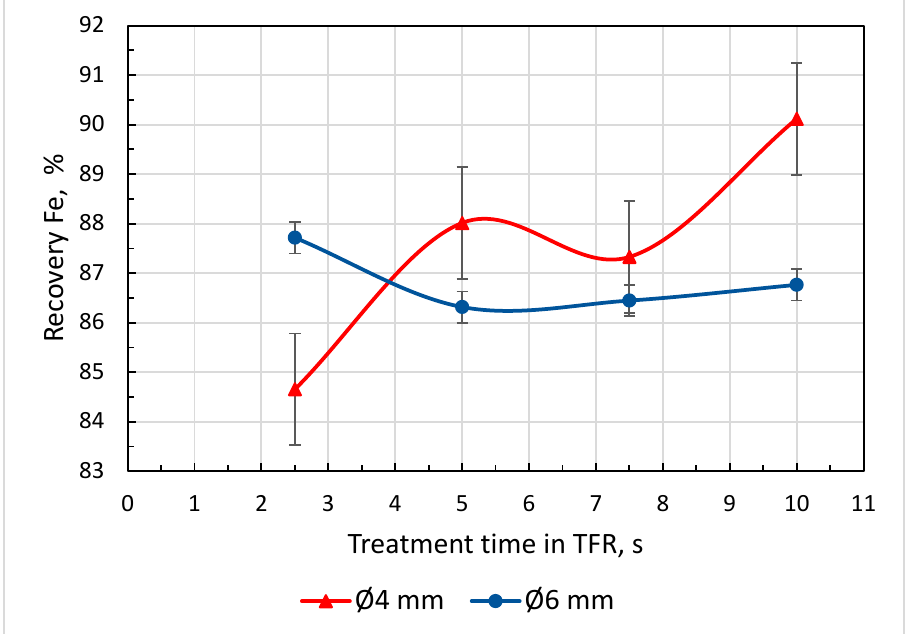
Figure 9. Dependence of iron recovery on suspension treatment time in TFRs having 4 and 6 mm inner diameters. CTAB dosage 20 g/t, microbubble dosage 0.21 mL/g. (Error bars represent the standard deviation obtained from 3 test repeats).